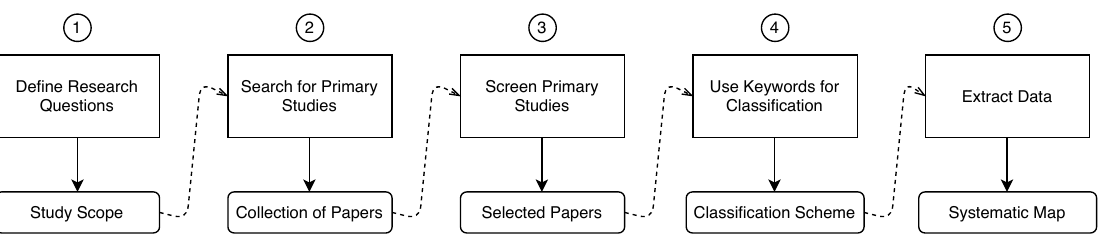
Figure 3. The mapping study steps performed in this